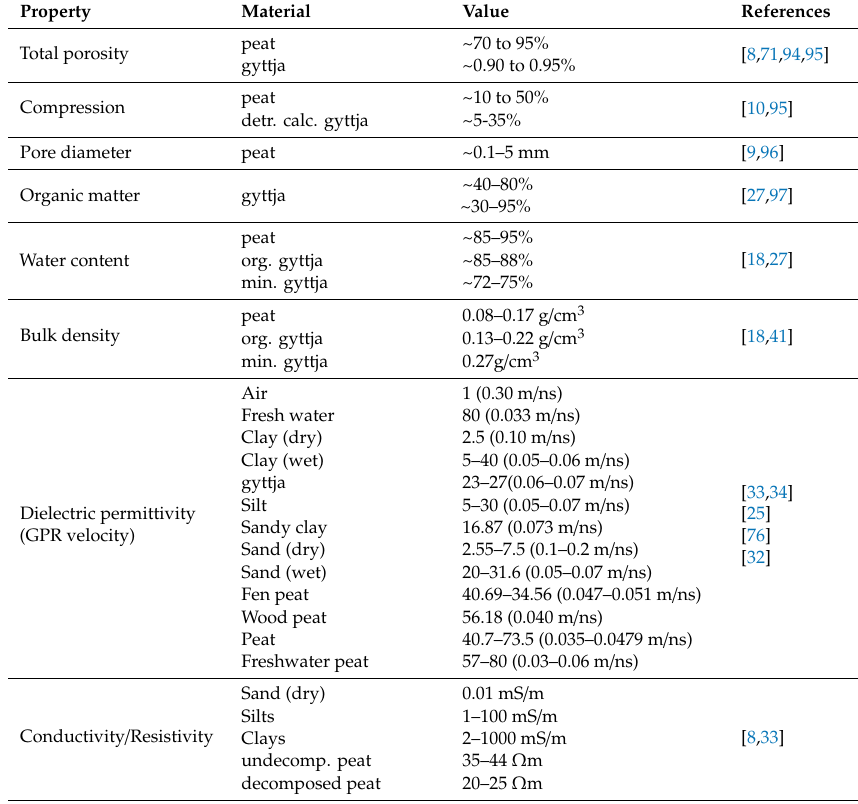
Table A1. Range of soil parameters of di ff erent sediments from field and laboratory studies taken from